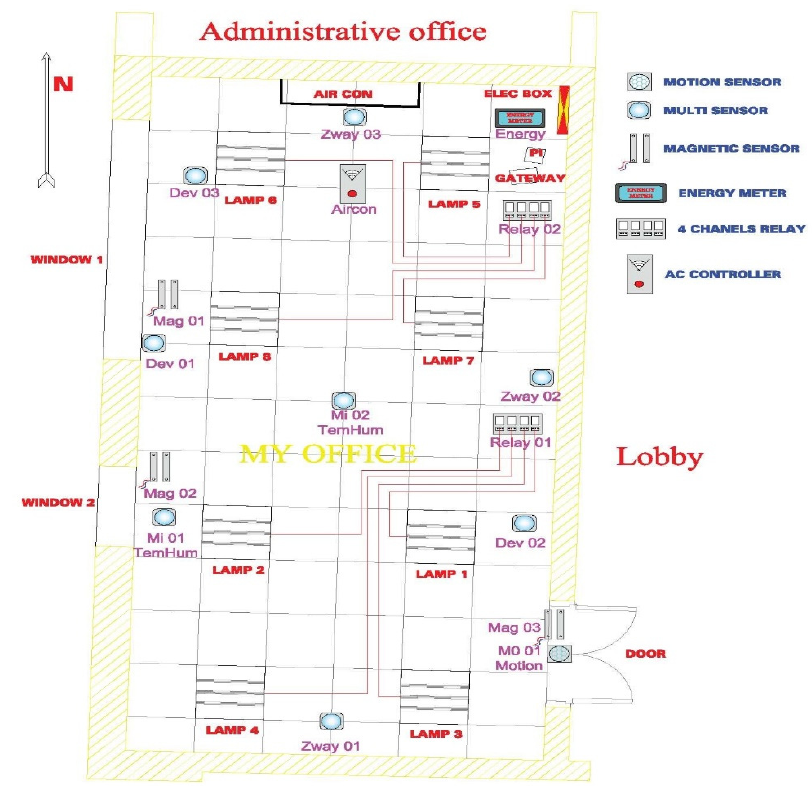
Figure 7. VHH sensor-network